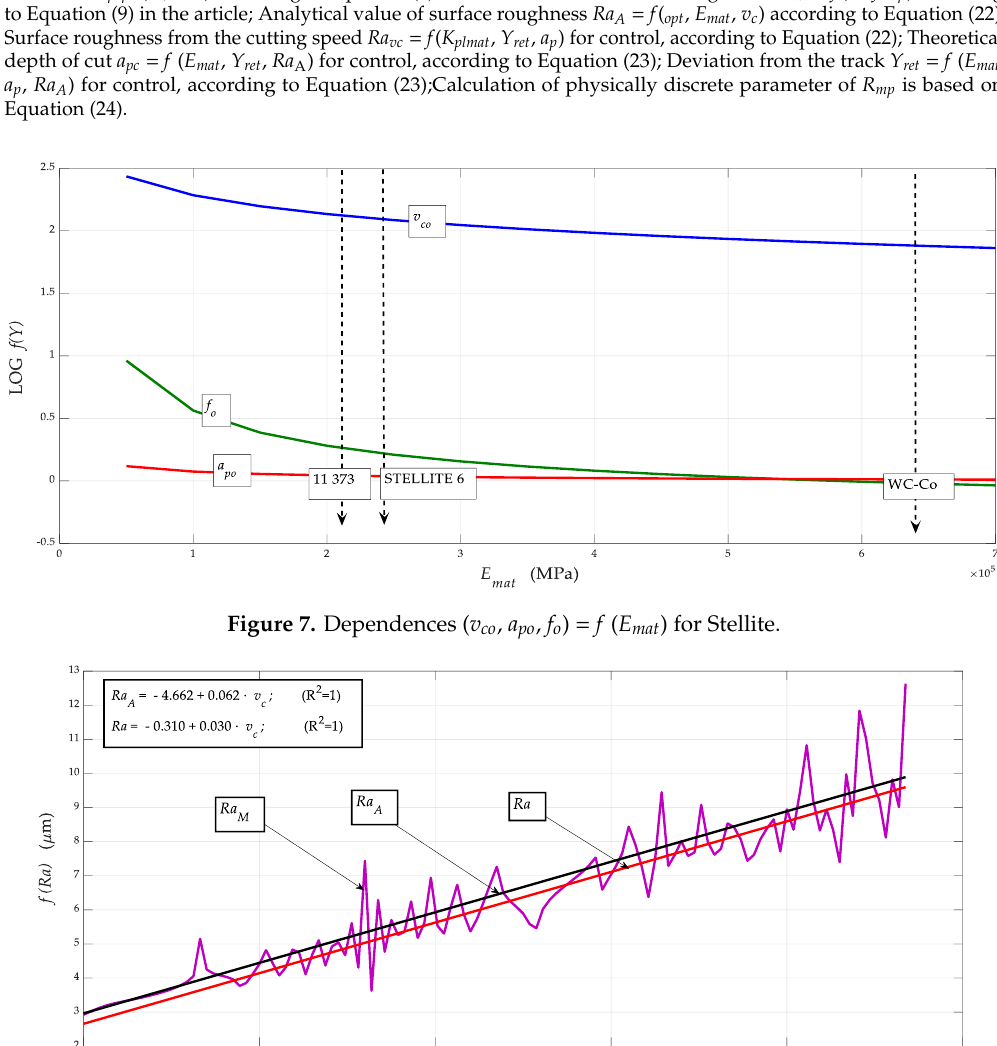
= f ( v Figure 8. Comparison of ( Ra M , Ra A , Ra ) = f ( v c ) according to values in the columns 7, 8 and 9 in Table 8; Figure 8. Comparison of ( Ra M , Ra A , Ra ) c ) according to values in the columns 7, 8 and 9 in Table 8; Ra M measurement data, Ra A according to Equation (21), above, and Ra according to Equation